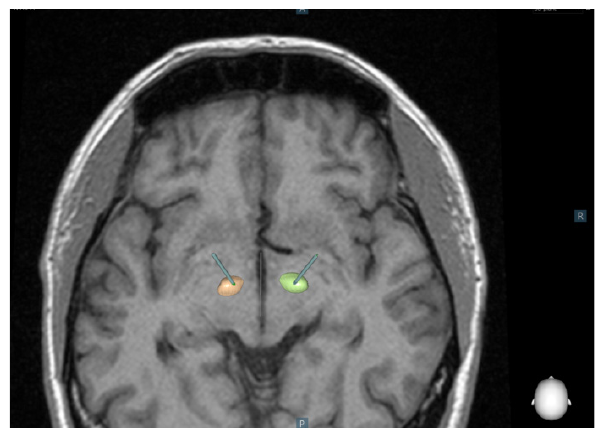
Fig. 1. Subthalamic nucleus (SureTune).